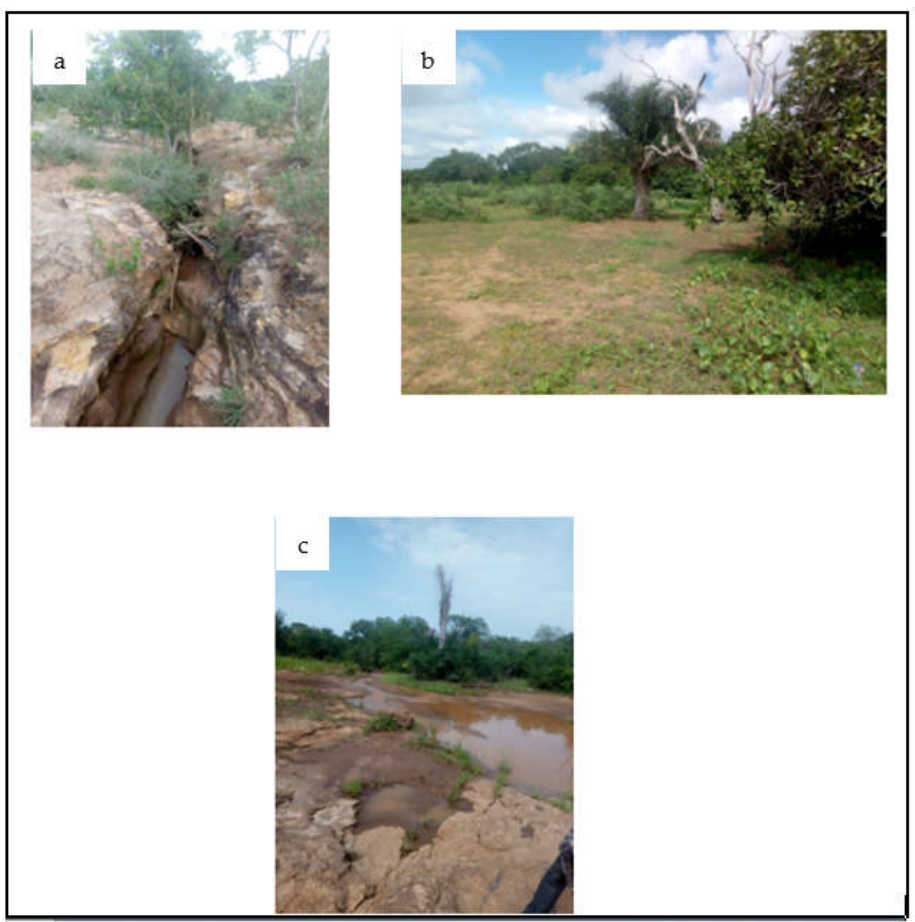
Figure 14. ( a ) View of a gully in the sandstone; ( b ) view of a gallery forest in the sandstone; ( c ) view of a hydrographic network in the